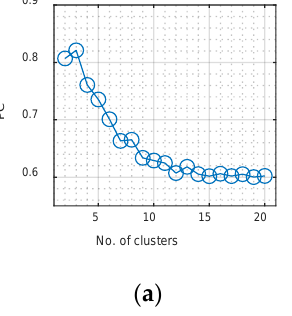
Figure 5. Comparison of cluster validation indices for various number of clusters: ( a ) partition coefficient; ( b ) modified partition coefficient; ( c ) partition entropy; and ( d ) Xie–Beni coefficient. As depicted in Figure 5, the maximum values for PC and MPC were obtained when the number of clusters was set to three. Likewise, the XB coefficient achieved its minimum value with three clusters. Despite the PE coefficient’s lowest value being obtained for two clusters, the simulation with three clusters resulted in a close value of the PE (i.e., 0.308 for two clusters and 0.322 for three clusters). Therefore, it can be concluded that three clusters were optimal for extracting the most representative scenarios from the studied dataset. Figure 6 depicts the three obtained cluster centers, which represent the scenarios further employed in the